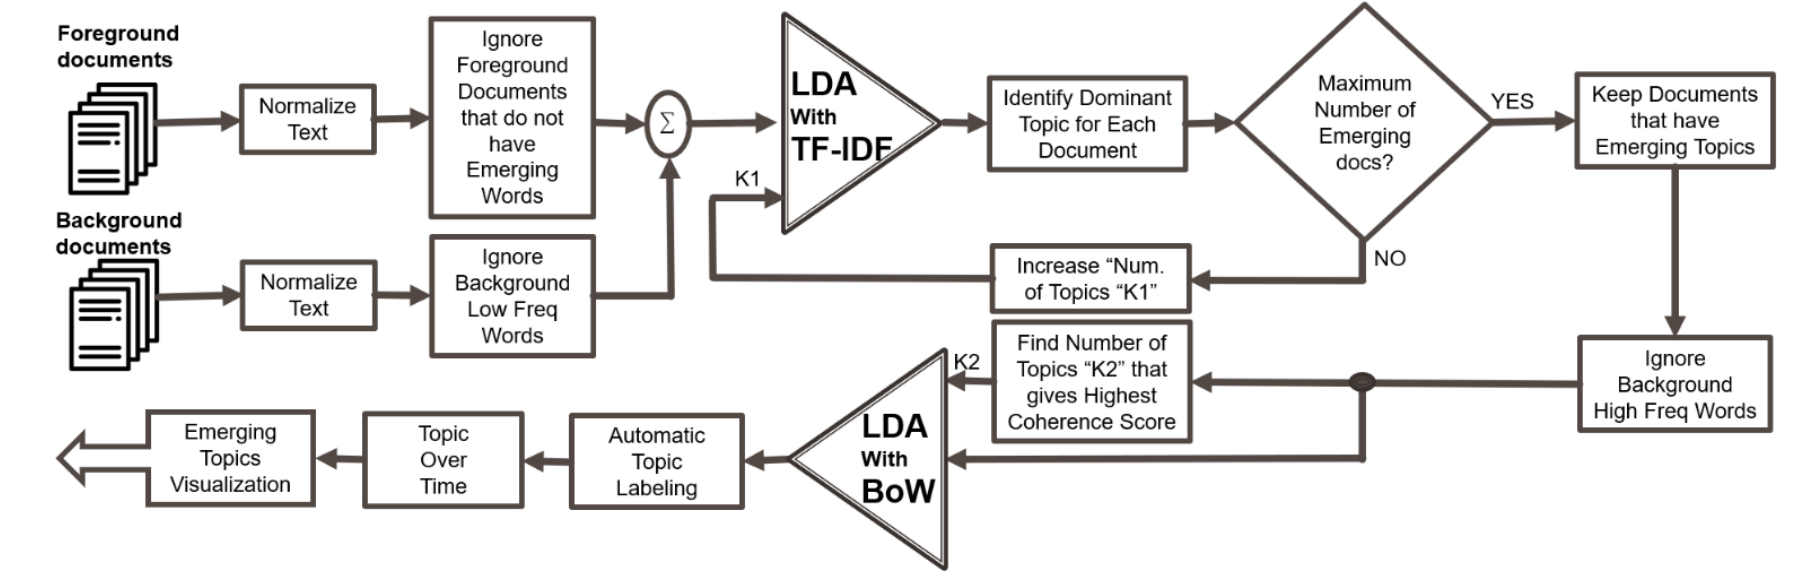
Figure 13. Emerging topic detection filtered-LDA Framework #2.